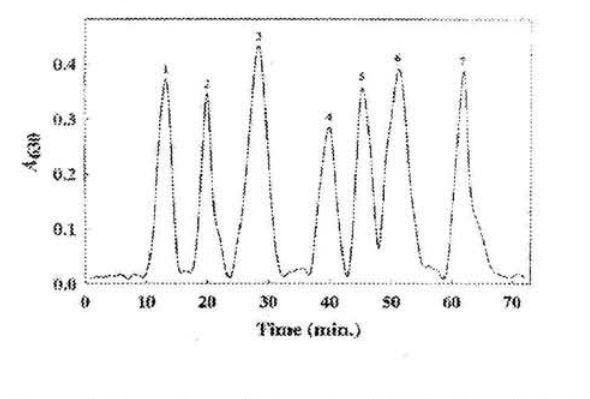
Figure 1. Separation of folates by HPLC. After elution with 10% (v/v) ethanol (see Material and Methods), folate standards were detected hy assay with L. rham-